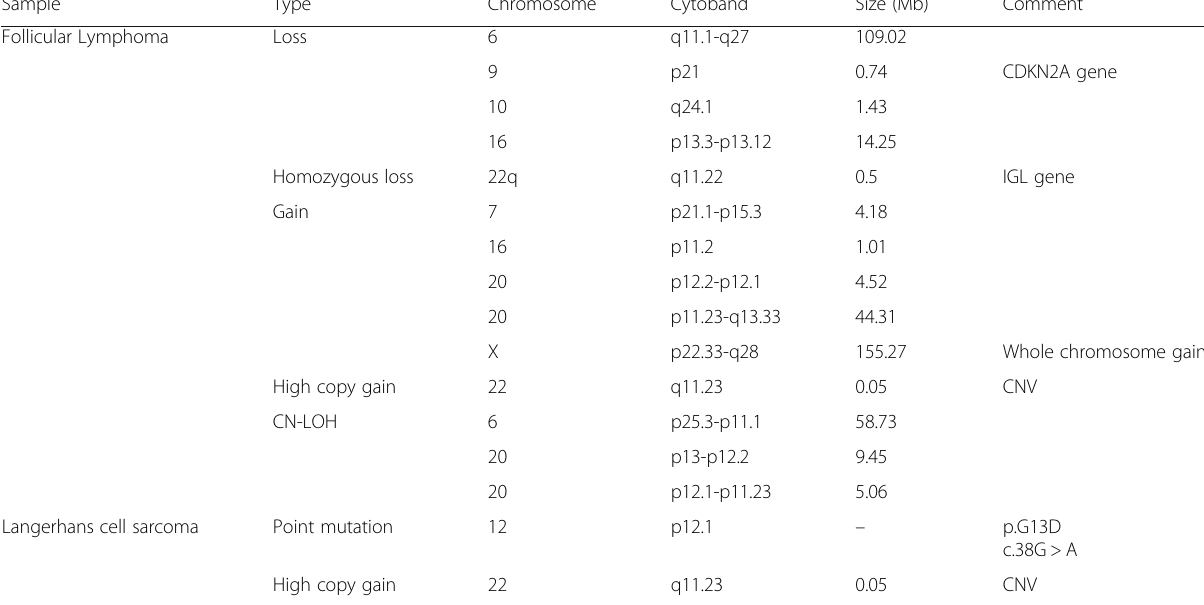
Table 3 Chromosomal abnormalities in Follicular lymphoma and Langerhans cell sarcoma detected by SNP microarray